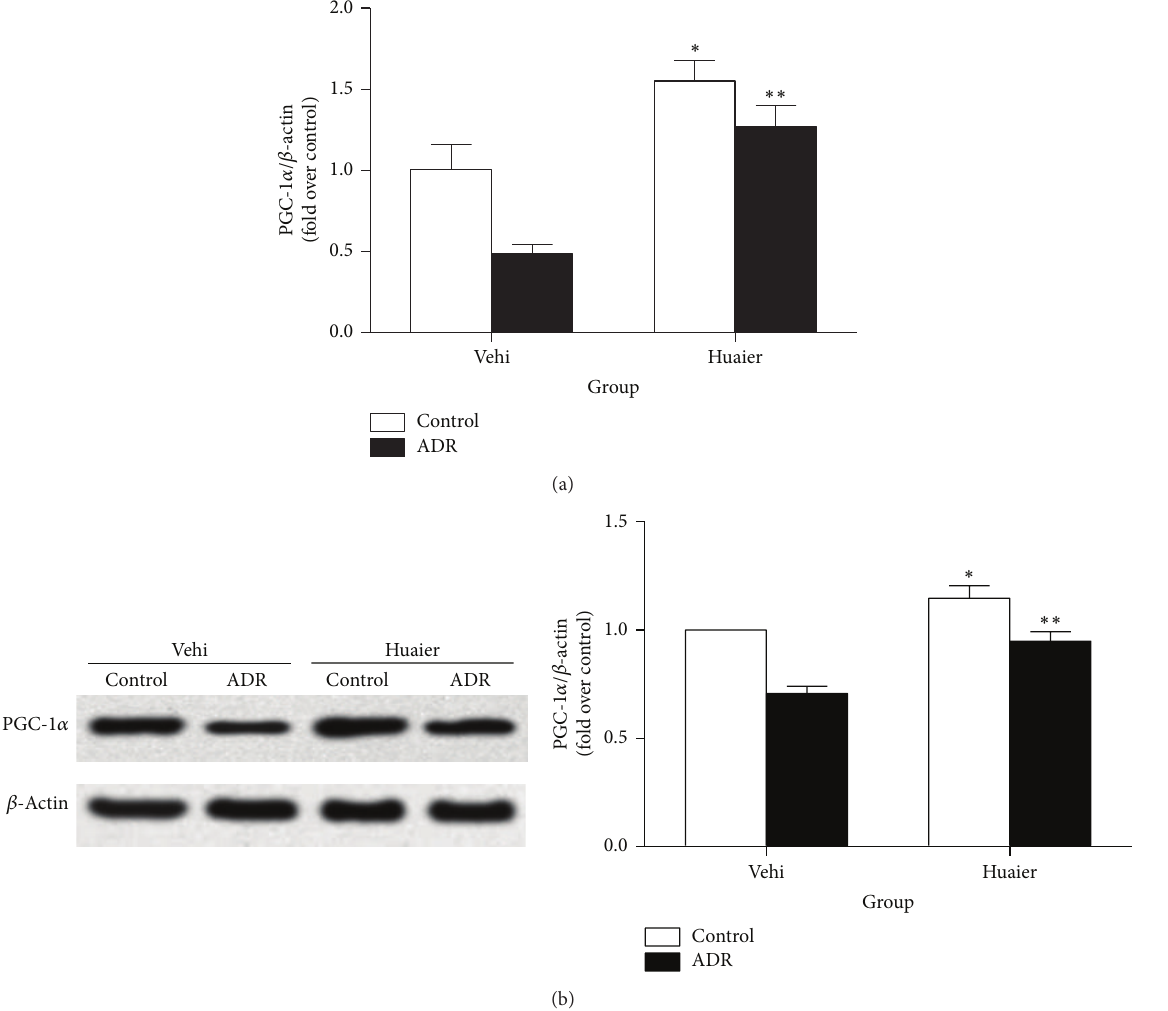
Figure 6: Huaier induced PGC-1 𝛼 expression in vitro . (a) Real-time RT-PCR of PGC-1 𝛼 . (b) Western blot of PGC-1 𝛼 . Left: representative immunoblots. Right: densitometric analysis. Podocytes were pretreated with Huaier (0.2 mg/mL) for 1h followed by incubation with ADR (200 nM) for further 24 h. Data are expressed as the means ± SD ( 𝑛 = 6 ). ∗ 𝑃 < 0.05 control of Huaier group versus control of vehicle group. ∗∗ 𝑃 < 0.05 versus ADR of Huaier group versus ADR of vehicle